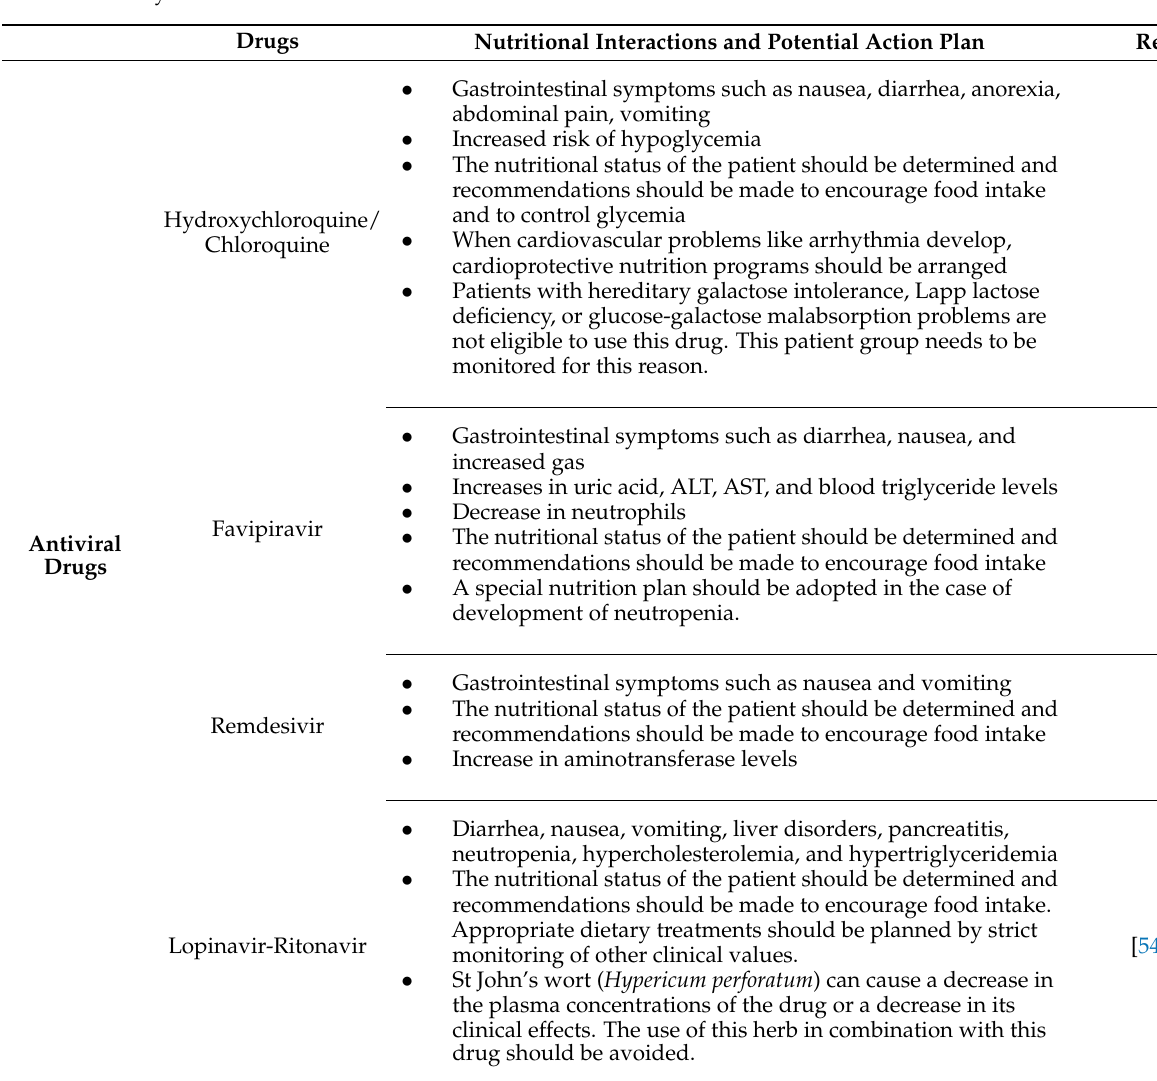
Table 2. Some cautions and precautions of drug and nutrition interactions in COVID-19 for healthcare practitioners: a